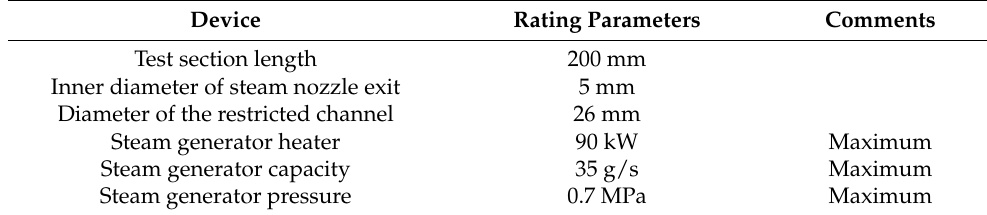
Table 10. The additional equipment in the test rig of Chen et al.